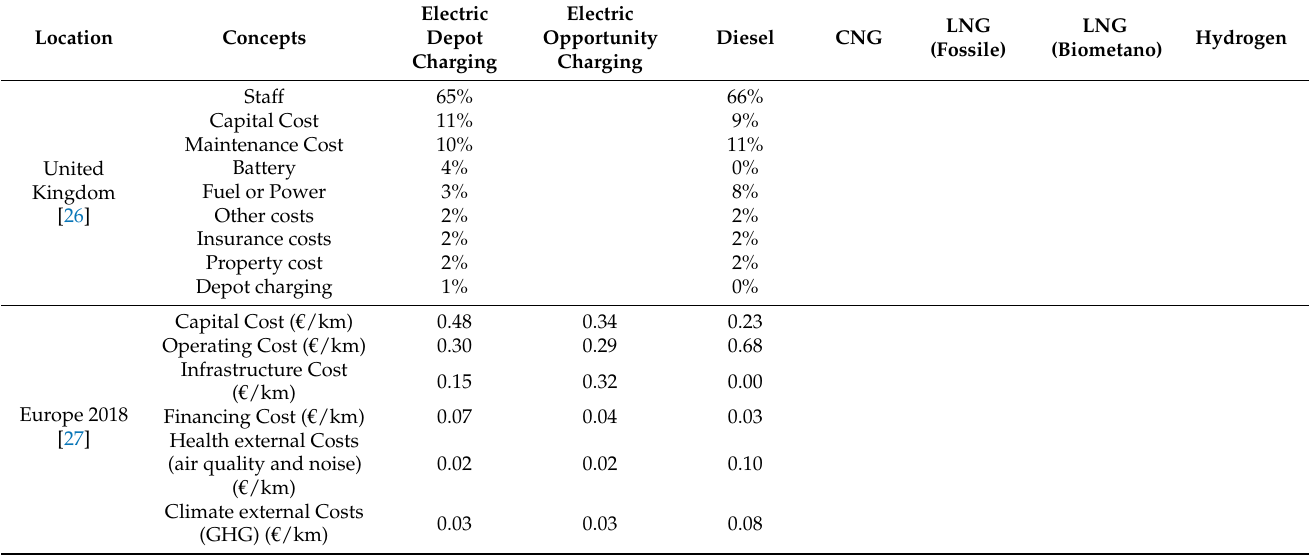
Table 9. TCO of different bus technologies based on literature